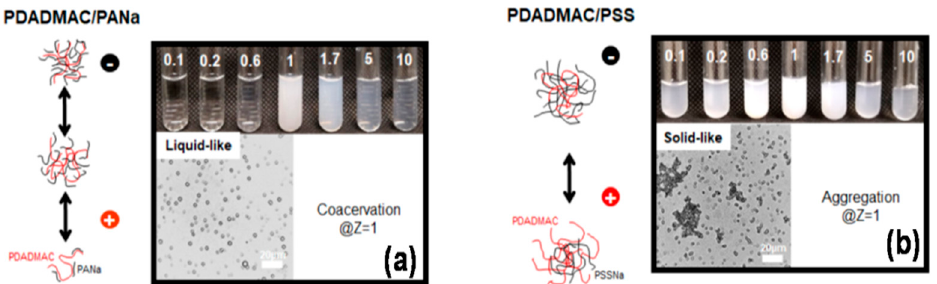
Figure 7. Photographs of the PEC dispersions taken at different Z values together with microscopic images taken at charge stoichiometry (Z = 1) of PDADMAC/PANa ( a ) and PDADMAC/PSSNa ( b ). Reprinted with from Polymers , 2021, 13, 3848. Copyright 2021 MDPI.